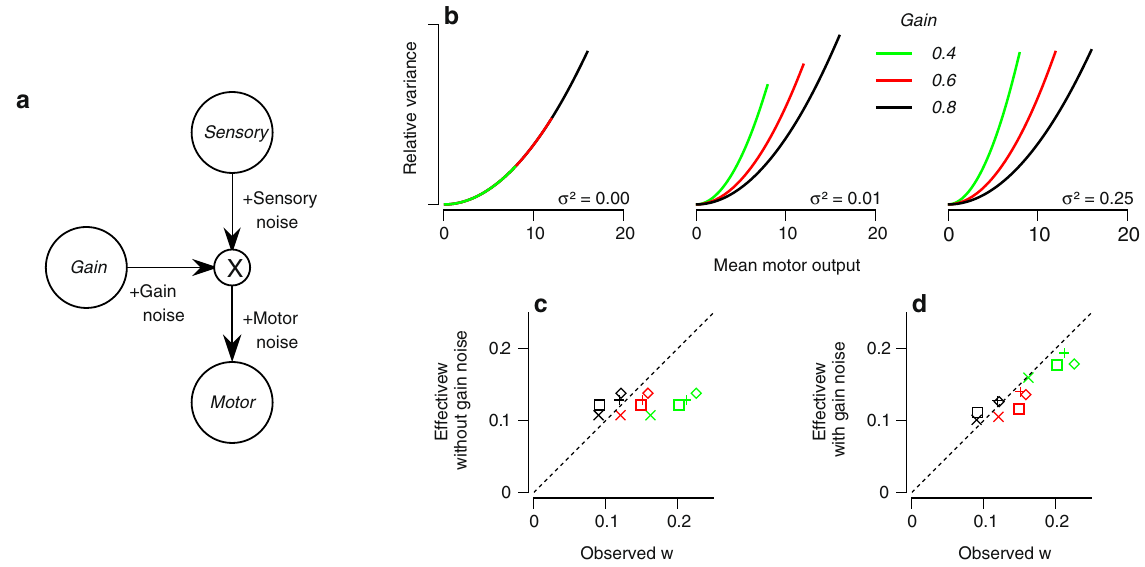
Fig. 3 The “ gain-noise ” model: effect of gain noise on the relationship between variance and mean eye speed in behavior. a Simpli fi ed model of sensory-motor transformations, where sensory input is transformed by the application of a gain signal to determine total motor output. b Motor variance as a function of mean behavioral output for the simple model (Eq. 1). From left to right, the three graphs show the predictions for gain noise with three different values of variance, σ 2 . Variance is plotted relative to the maximum across gains for each value of noise variance. Green, red, and black curves show predictions for three different mean gains at each value of noise variance. c The effective value of the Weber fraction, w eff , inferred from a fi t of the simple model without gain noise is plotted against the value of the Weber fraction, w , fi tted directly to the data for each target size separately (colors correspond to target size, as in Fig. 1c). Plus signs and diamonds indicate right and left pursuit, respectively, for Monkey R. x'es and squares indicate right and left pursuit for Monkey X. Green, red, and black correspond to results from 2, 6, and 20 deg targets, respectively. d As in panel c , but with gain noise included in the model. Source data are provided as a Source Data fi